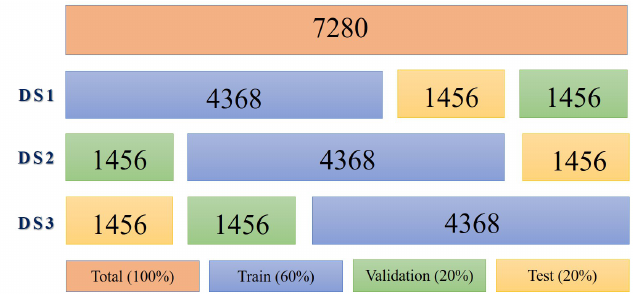
Figure 8. Image distribution in each of the datasets (DS).